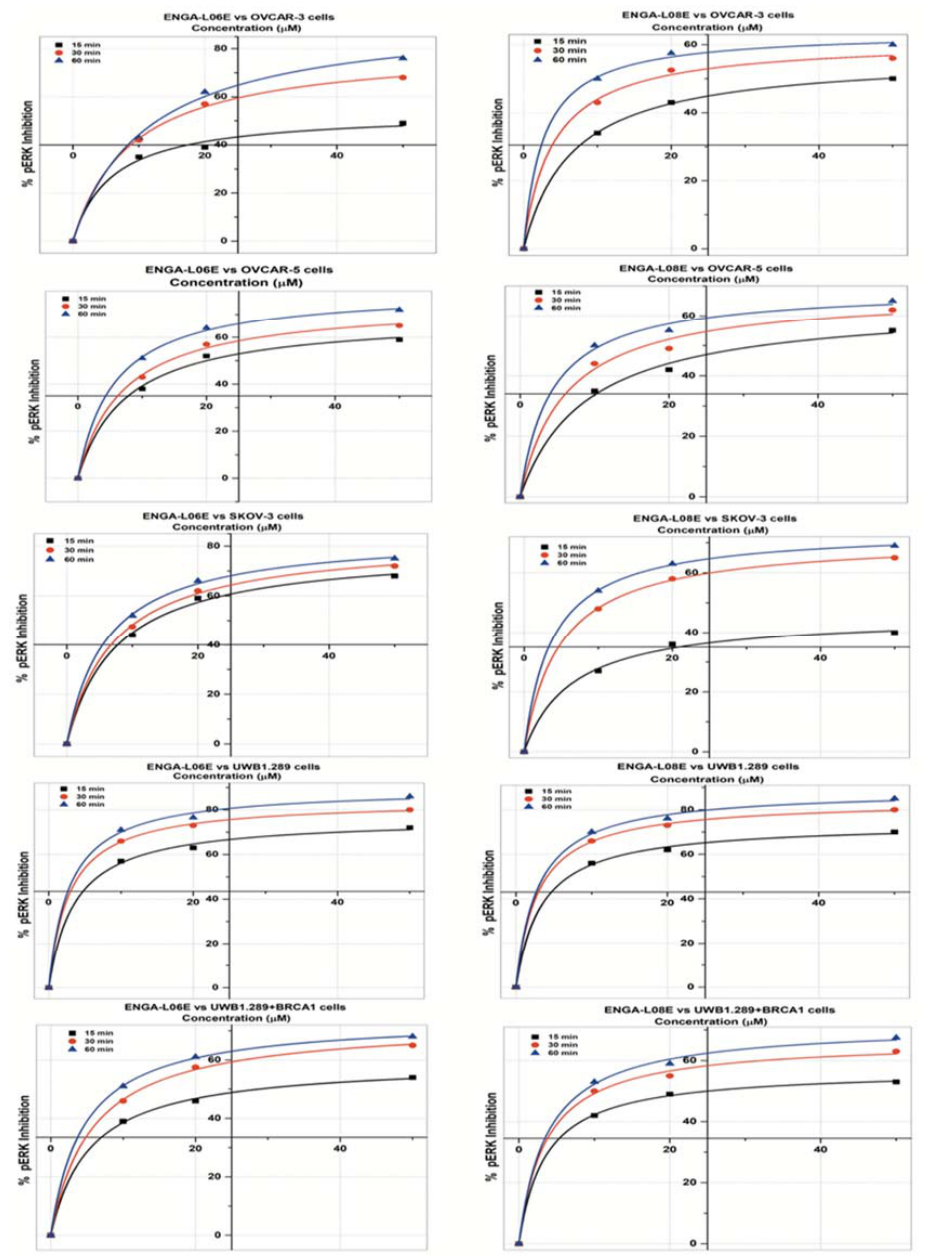
Figure 1. Michaelis Menten model (y = Vmax ∗ x / (Km + x) inhibition curves of the ERK phosphorylation by ENGA-L06E and ENGA-L08E in SKOV-3, OVCAR-3, OVCAR-5, UWB1.289, UWB1.289 + BRCA1 human ovarian cancer cell lines, treated with 10, 20, and 50 µ M at di ff erent time conditions (15, 30, 60 min) ( p <